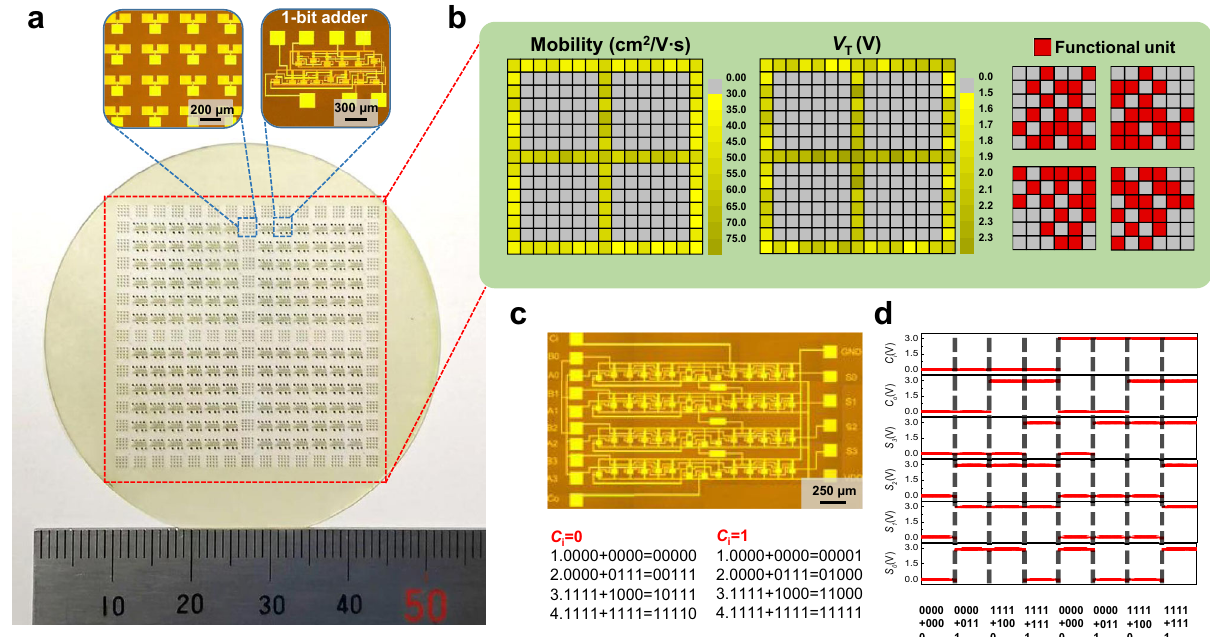
Fig. 5 Wafer-scale integrated circuits built from MoS 2 FETs. a Photograph of a 2-inch MoS 2 wafer with 1-bit full-adder arrays as functional circuits in the center, and MoS 2 TG-FET arrays used as monitoring devices locating in the surrounding regions. All MoS 2 TG-FETs and 1-bit full-adders are fabricated within the red dashed square. The zoom-ins of blue dashed boxes are optical microscope images of the corresponding MoS 2 TG-FET and 1-bit full-adder arrays. b Wafer maps of mobility (left) and V T statistics (center) extracted from devices in the surrounding regions. The yellow scale bars show mobility and V T values. Each block ’ s color scale represents a value averaged from 16 FETs, and the entire wafer has 81 blocks. The right graph illustrates the yield of 1-bit full-adder circuit arrays. The red and gray squares represent the proportion of working and nonworking circuits, respectively. c Optical microscope image of a 4-bit full adder under which is the truth table for logical combinations. d Functional measurements of the 4-bit full adder with V DD = 3 V. The 4-bit full-adder was tested using a series of input combinations (A, B) in the following order: (0000 + 0000, 0000 + 0111, 1111 + 1000, 1111 + 1111) with C = 0 and C = 1. The y axes are the voltage of carry input ( C C S S S S i i i ) and carry output ( o ), and the output voltage of sum 0 ( 0 ), sum 1 ( 1 ), sum 2 ( 2 ), sum 3 ( 3